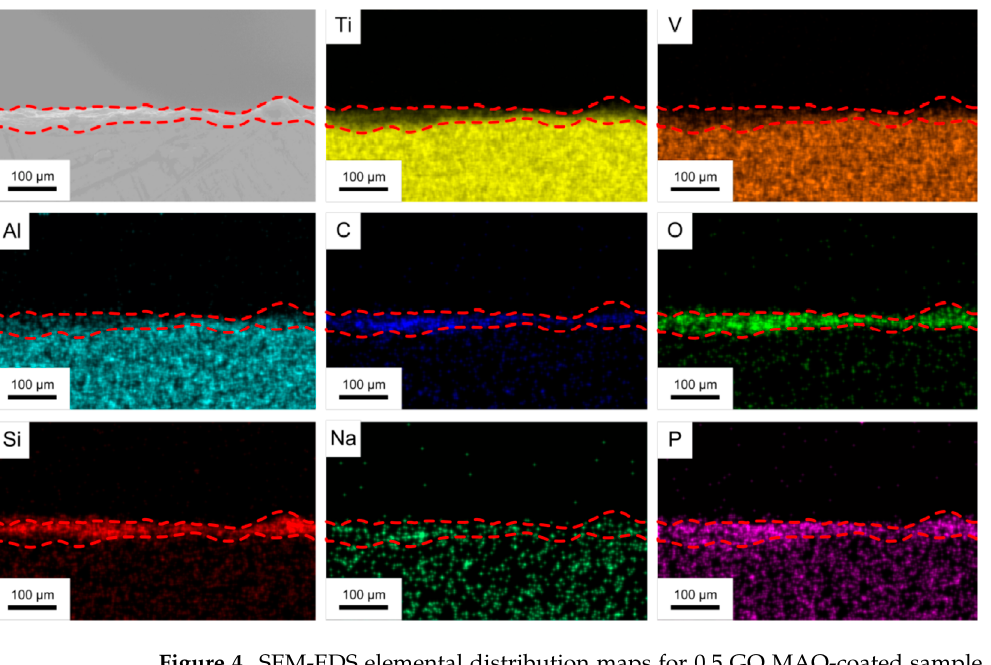
Figure 4. SEM-EDS elemental distribution maps for 0.5 GO MAO-coated sample. The coating is indicated by red dashed lines.